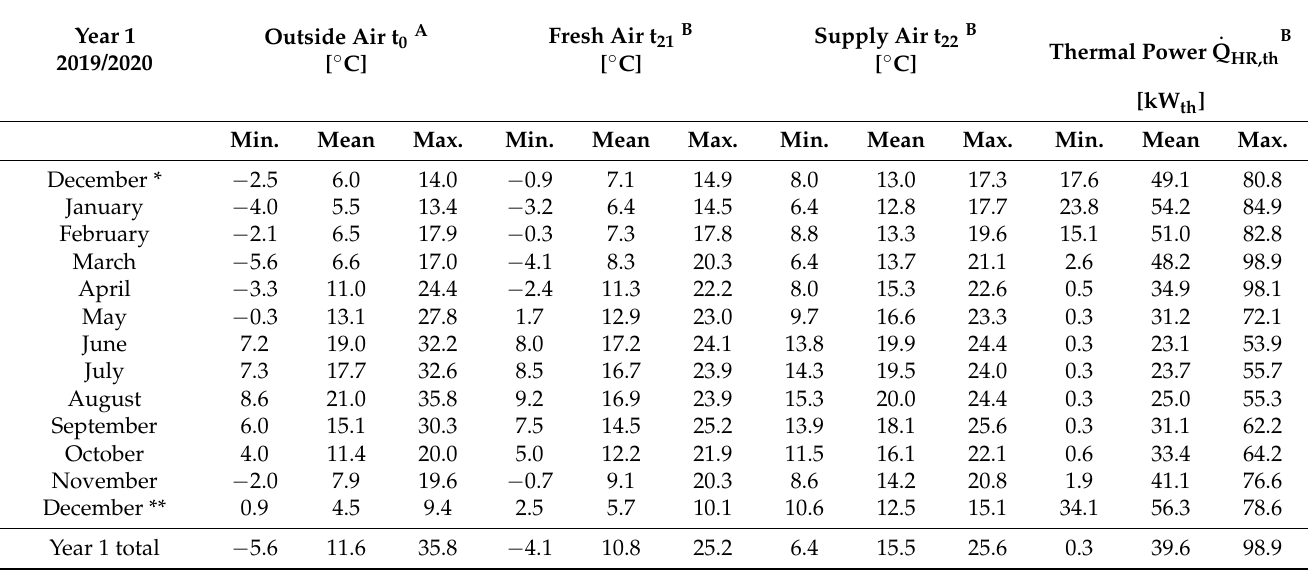
Table 1. Outside, fresh and supply air temperatures, and the thermal power of the heat exchangers . Q HR,th (minimum, maximum, and monthly mean values) on a monthly base for the first trial